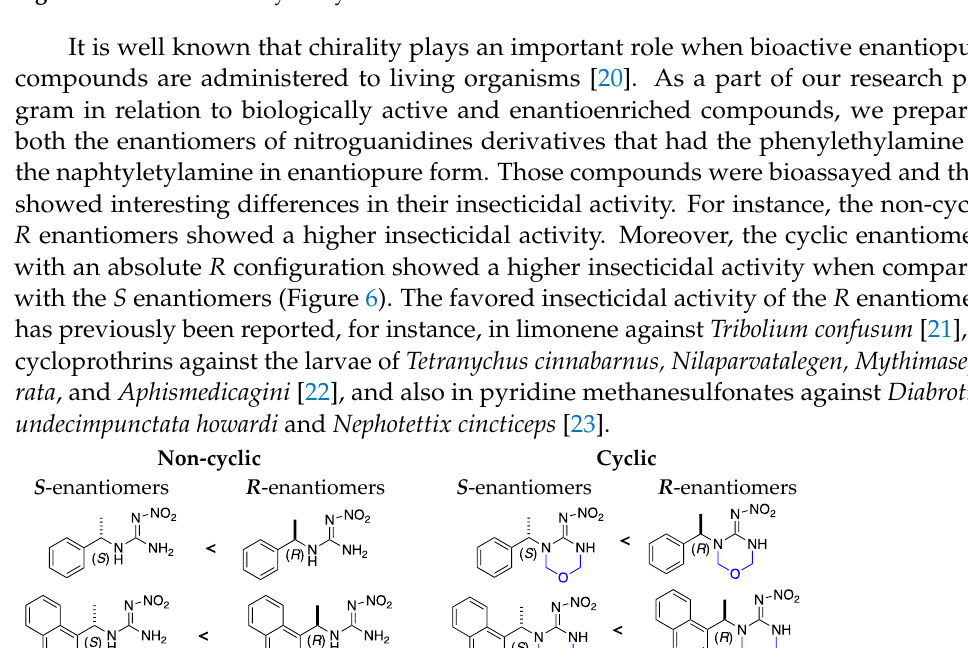
Figure 5. Structure – activity analysis of new neonicotinoids. Figure 5. Structure–activity analysis of new neonicotinoids.